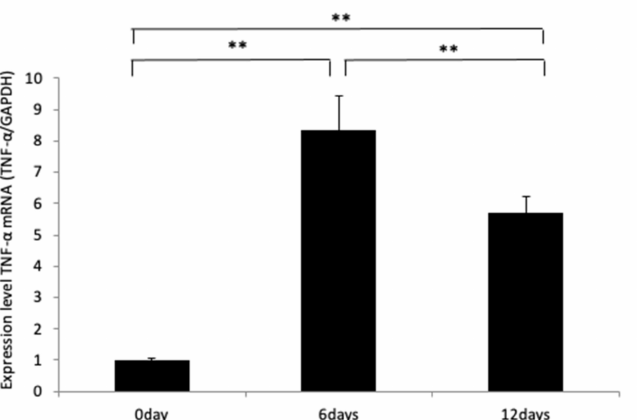
Figure 3. Time course of TNF- α expression by WT mice with MOPs. The alveolar bones of the left side maxillary first molar were excised after 0, 6 and 12 days with MOPs to evaluate the expression of TNF- α mRNA around the left maxillary first molar after MOPs. TNF- α mRNA expression was evaluated by real-time RT-PCR. The levels of TNF- α mRNA were normalized to the levels of GAPDH. The results are presented as the mean ± standard deviation ( n = 4). ** p < 0.01 indicated significant differences, which were analyzed by using the Scheffe’s